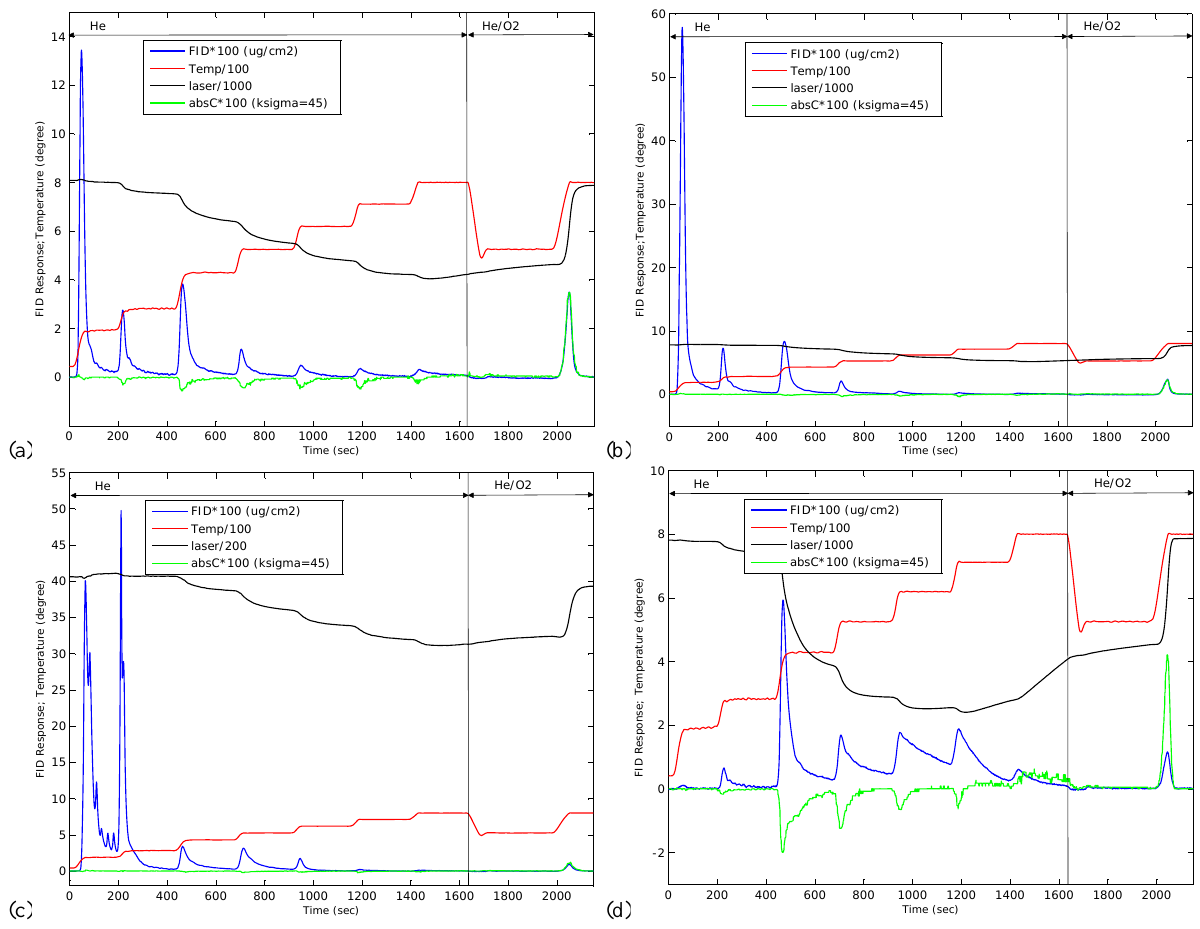
Fig. 2. Thermograms from the analysis of toluene photo-oxidation aerosol products (a) , α -pinene photo-oxidation aerosol products (b) , levoglucosan (c) , and fulvic acid (d) . The protocol used for the analysis has the following steps in the He-mode: He-4 at 550 ◦ C, He-5 at 650 ◦ C, He-6 at 750 ◦ C and He-7 at 850 ◦ C, each of 240s. absC*100 ksigma=45) is the amount of PC formed/released, multiply by 100, as calculated by the laser attenuation and σ =45m 2 /gC (Boparai et al.,